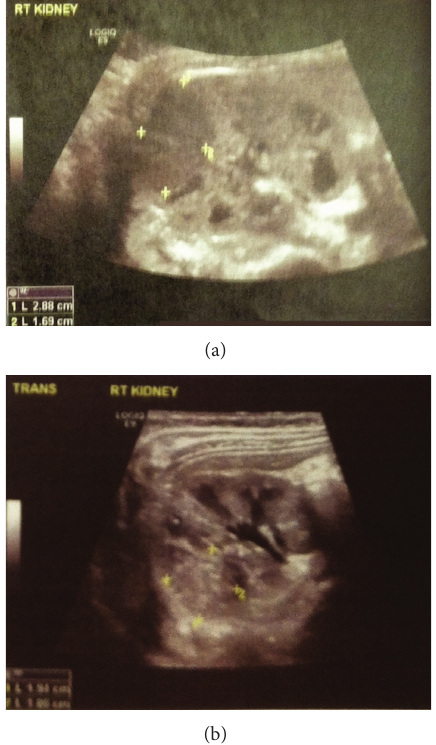
Figure 2: (a) Abdominal ultrasound showing an enlarged right kidney with a large hypoechoic region with no corticomedullary differentiation before chemotherapy treatment; (b) decrease of right kidney large hypoechoic lesion dimensions after 4 months of